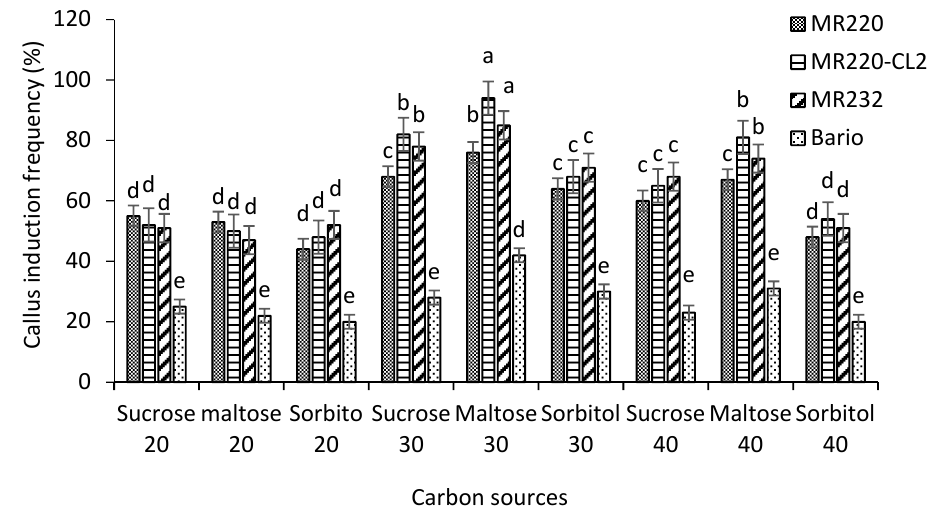
Figure 4. Callus induction frequency of MR220, MR220-Cl2, MR232, and Bario varieties cultured on MS media supplemented with 3 mg/L 2,4-D treated with different carbon sources were evaluated. Mean values marked with the same letters do not differ significantly ( p ≤ 0.05) in Tukey’s test. Vertical bars represent ± SD ( n = 3).